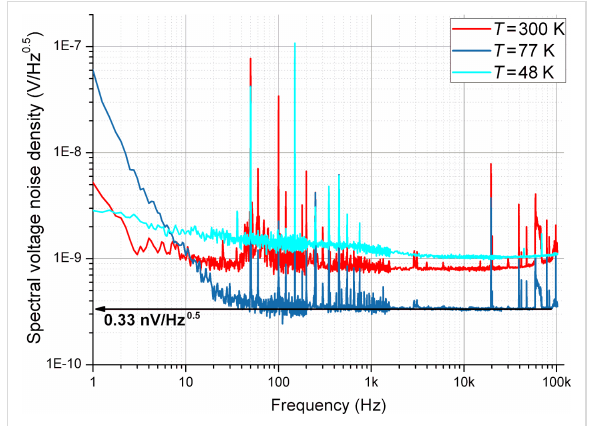
Figure 5: The voltage noise spectral density of the cryogenic differen- tial parallel BJT amplifier as a function of the frequency for three differ- ent temperatures. A spurious interference at 50 Hz and its harmonics are visible in the spectrum.